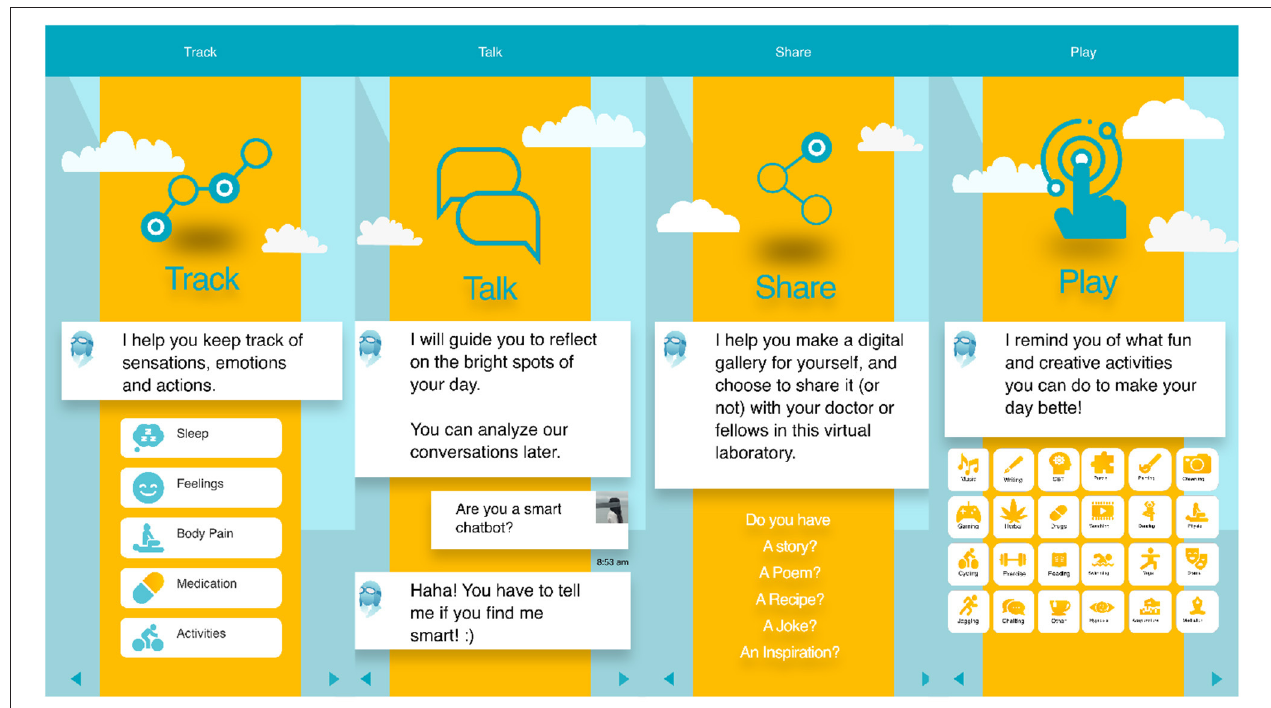
FIGURE 4 | Features of PlaythePain App. The app allows uses to track their pain experience in ways similar to conventional pain diaries. Data-generation via play is supported by features including: Talk, where an interactive chatbot encourages conversations about various topics which the player selects; Share, a social-media like forum for sharing art and ideas; and Play, a catalog of various playful activities that are coached through third-party applications, either suggested by researchers or introduced to the forum by